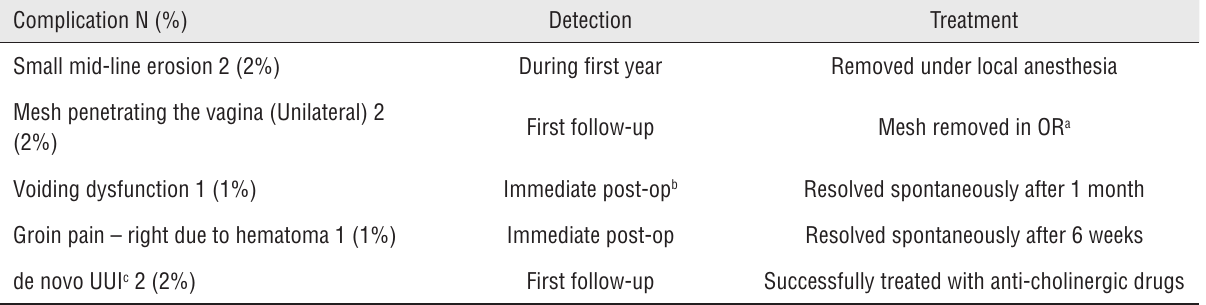
Table 1 - Long-term complications and treatment.